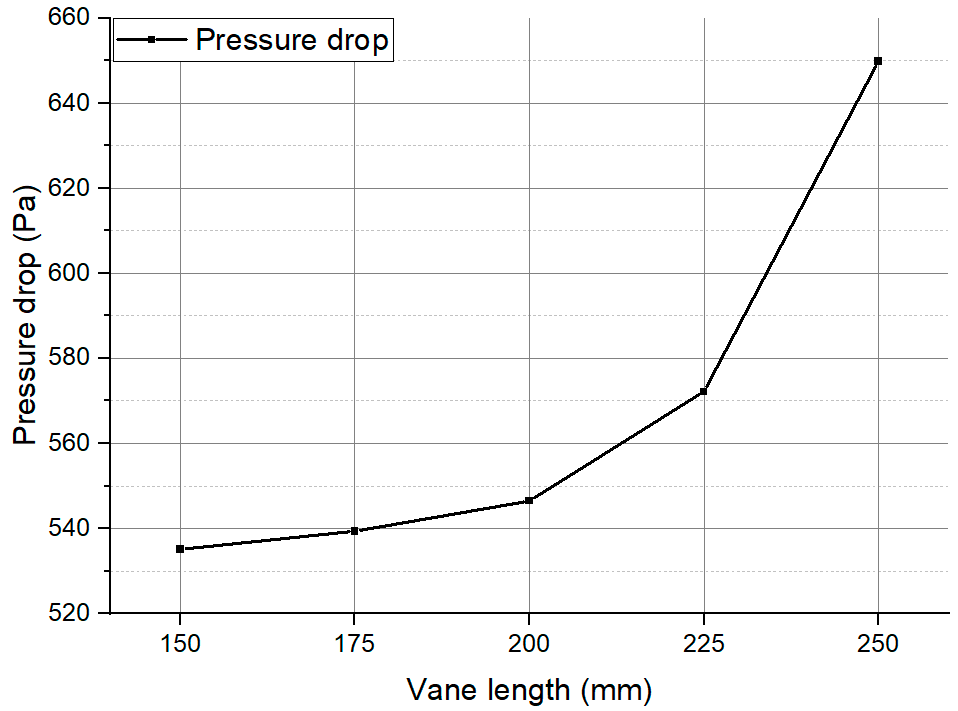
Figure 15. Pressure drop according to the vane length in the inner vane reverse type.